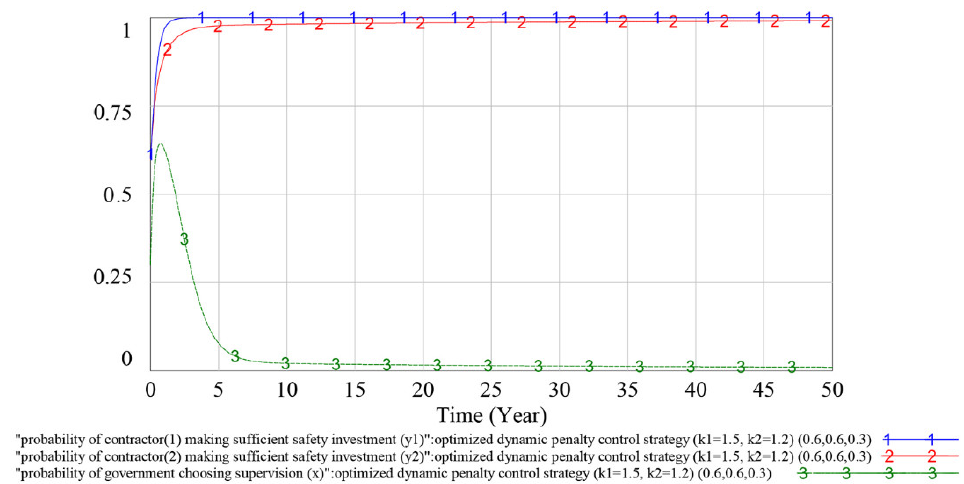
Figure 15. Simulation results under optimized dynamic penalty control strategy (initial value ( y 1 = 0.6, y 2 = 0.6, x = 0.3)).